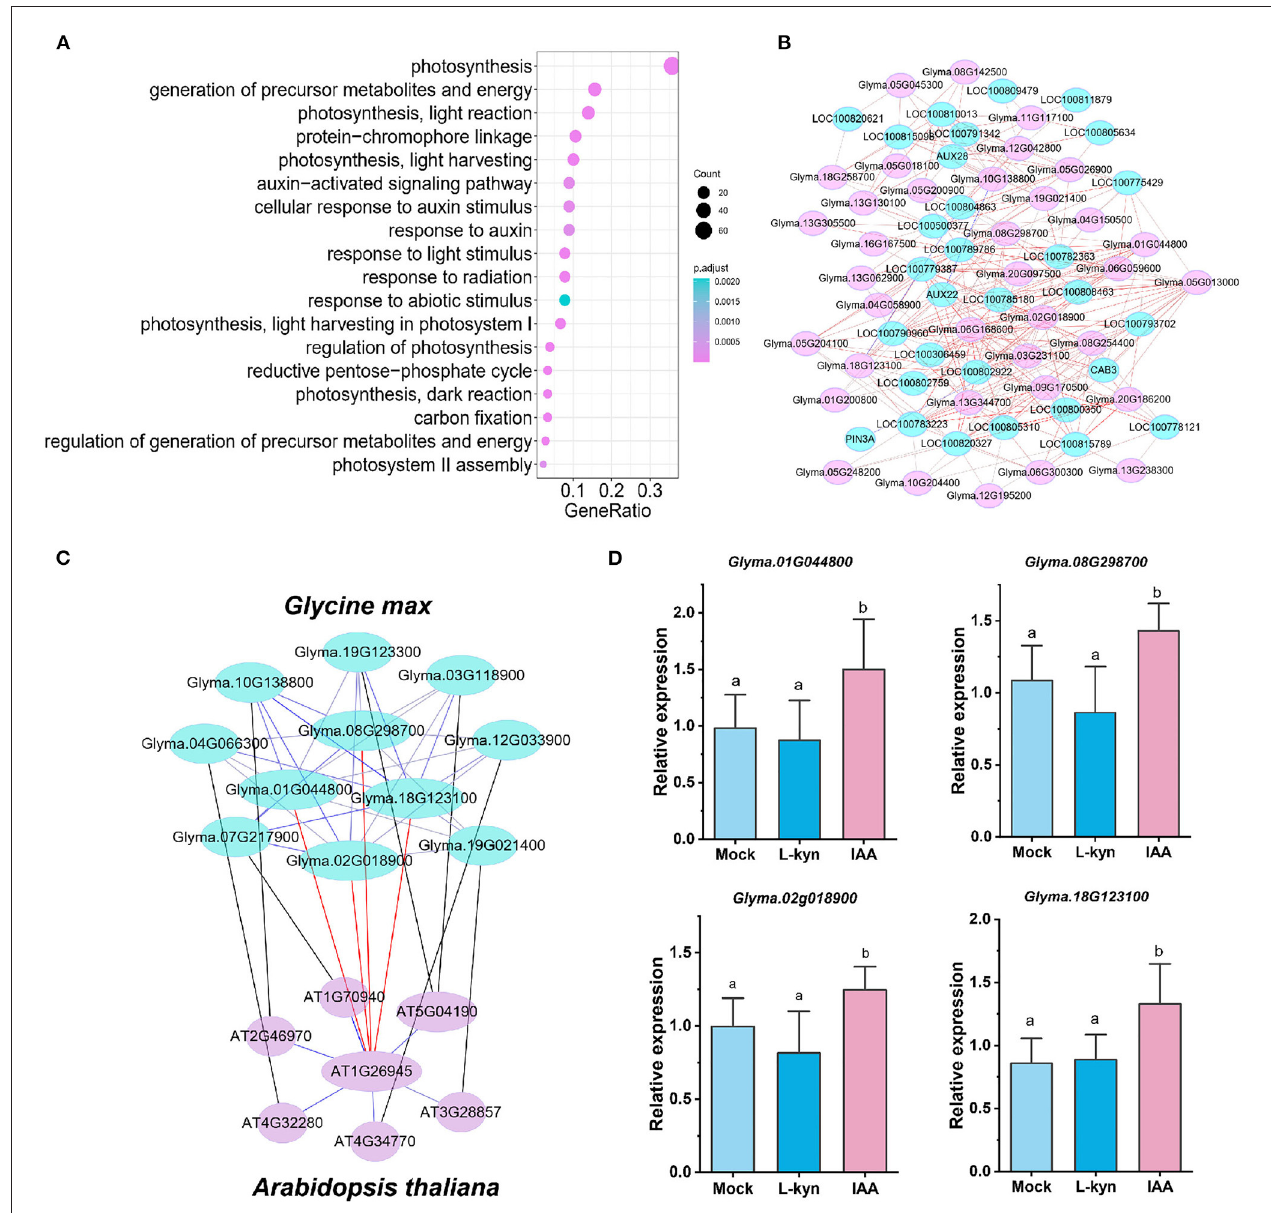
FIGURE 5 | Construction of a GmPRE6 s based submodule regulating hypocotyl elongation. (A) GO analysis of TFs in the cyan module. (B) Co-expression network containing light and auxin response TFs and their closely related genes in the cyan module. (C) A conserved PRE6 based submodule regulating hypocotyl elongation between Glycine max and Arabidopsis thaliana . (D) Expression of GmPRE6s in the hypocotyl after 2h treatment of exogenous IAA and Kyn. Data are presented as mean ± SD ( n = 3). Different letters (a, b) indicate significant difference (two-tailed Student’s t -test).